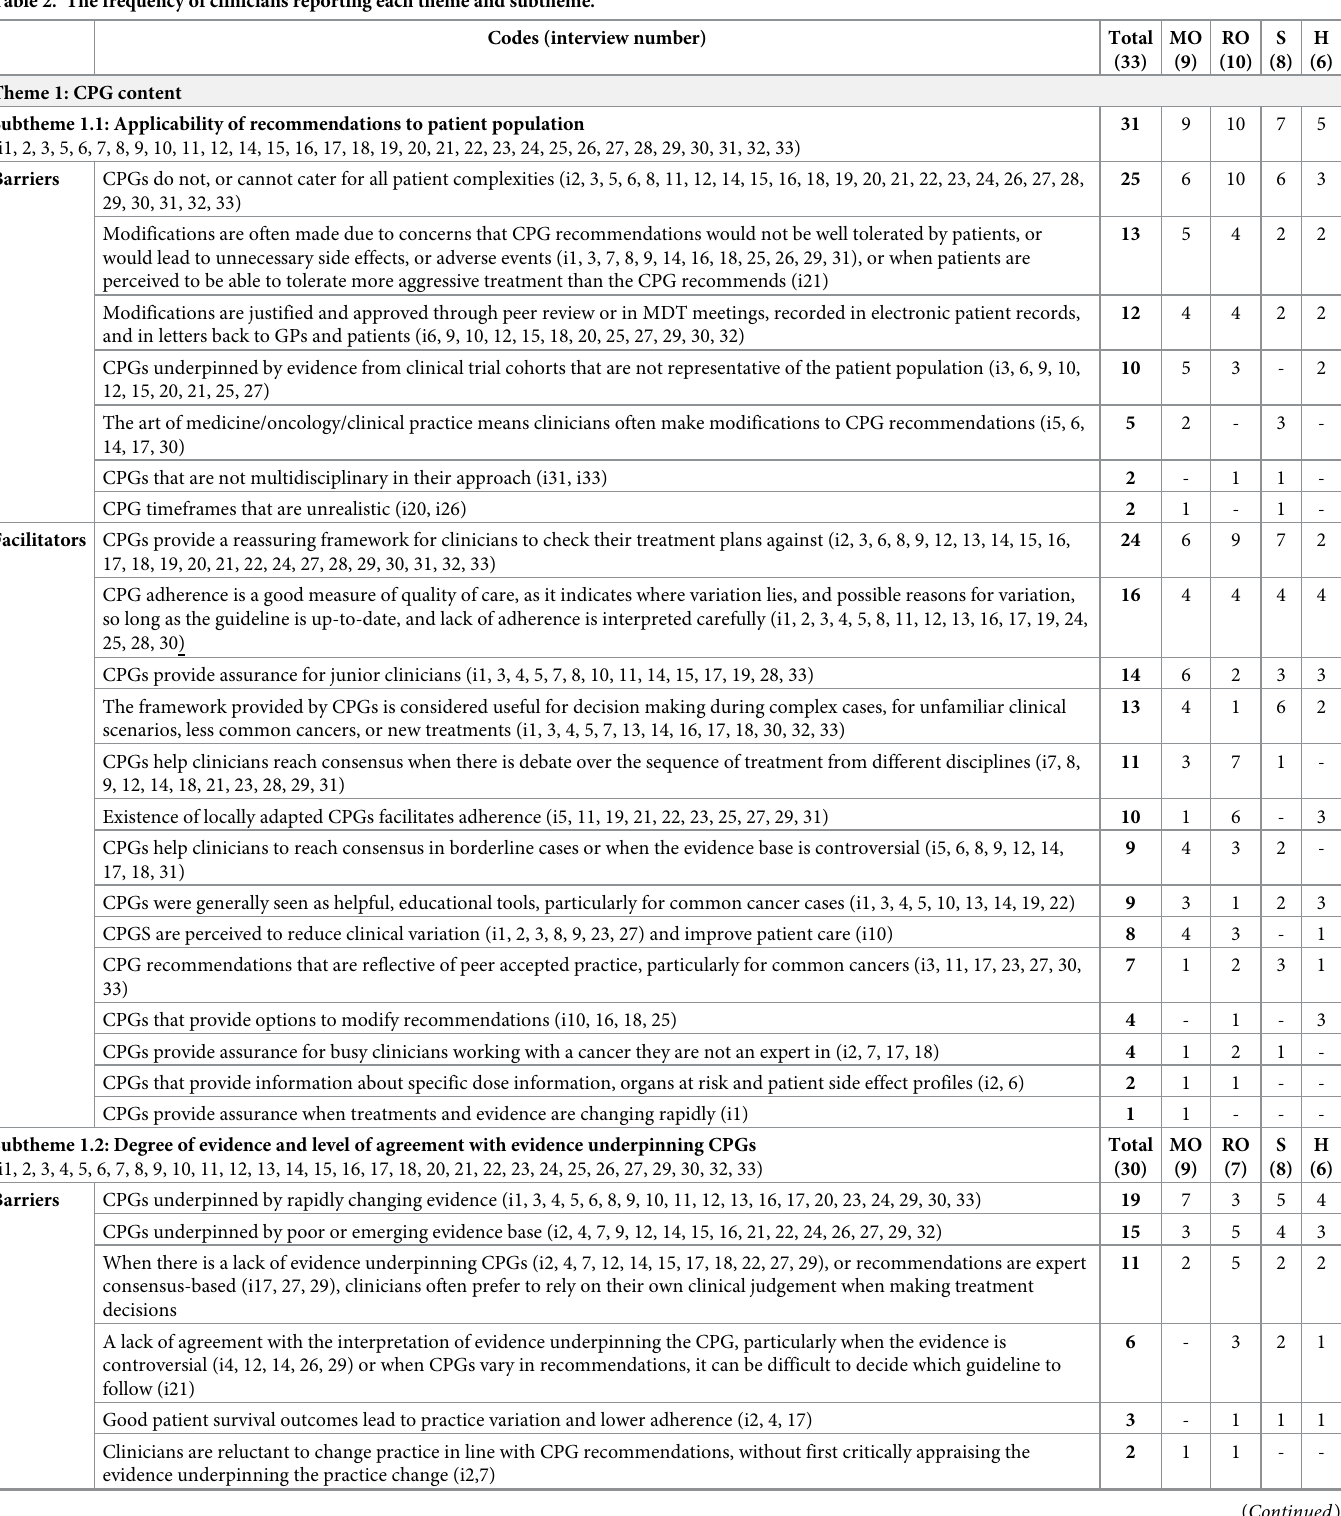
Table 2. The frequency of clinicians reporting each theme and subtheme.